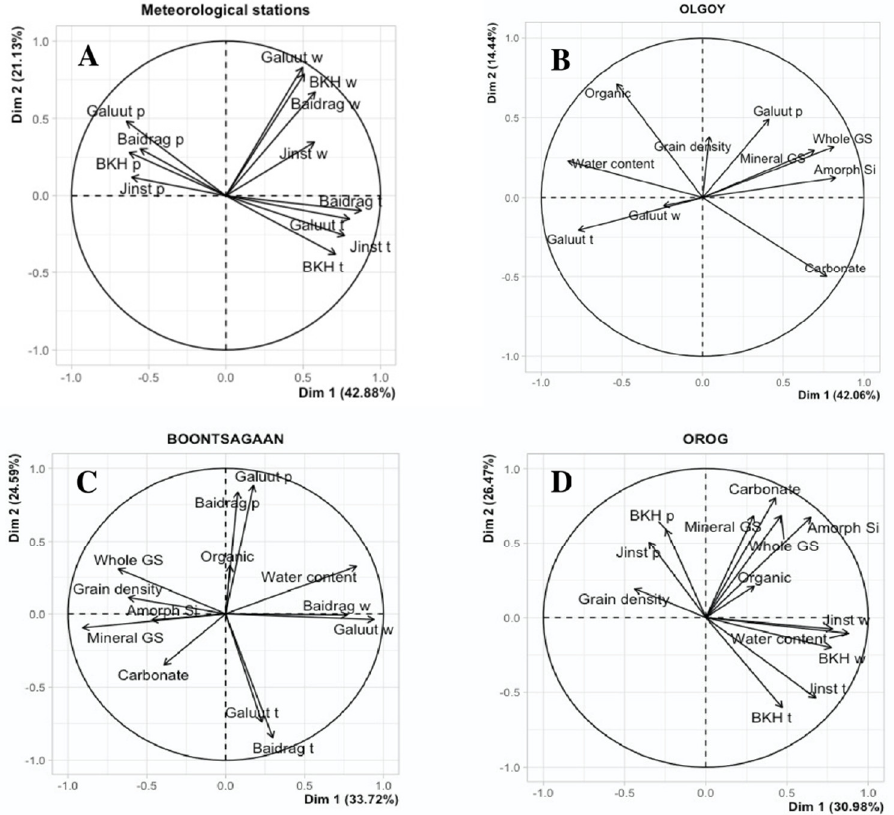
Figure 3. PCA variable graph. ( A ) All meteorological stations; ( B ) Olgoy Lake sediment proxies with the Galuut station; ( C ) Boontsagaan Lake sediment proxies with the Galuut and Baidrag stations; and ( D ) Orog Lake sediment proxies with the Bayankhongor (BKH) and Jinst stations. T stands for temperature, w stands for wind, and p stands for precipitation.